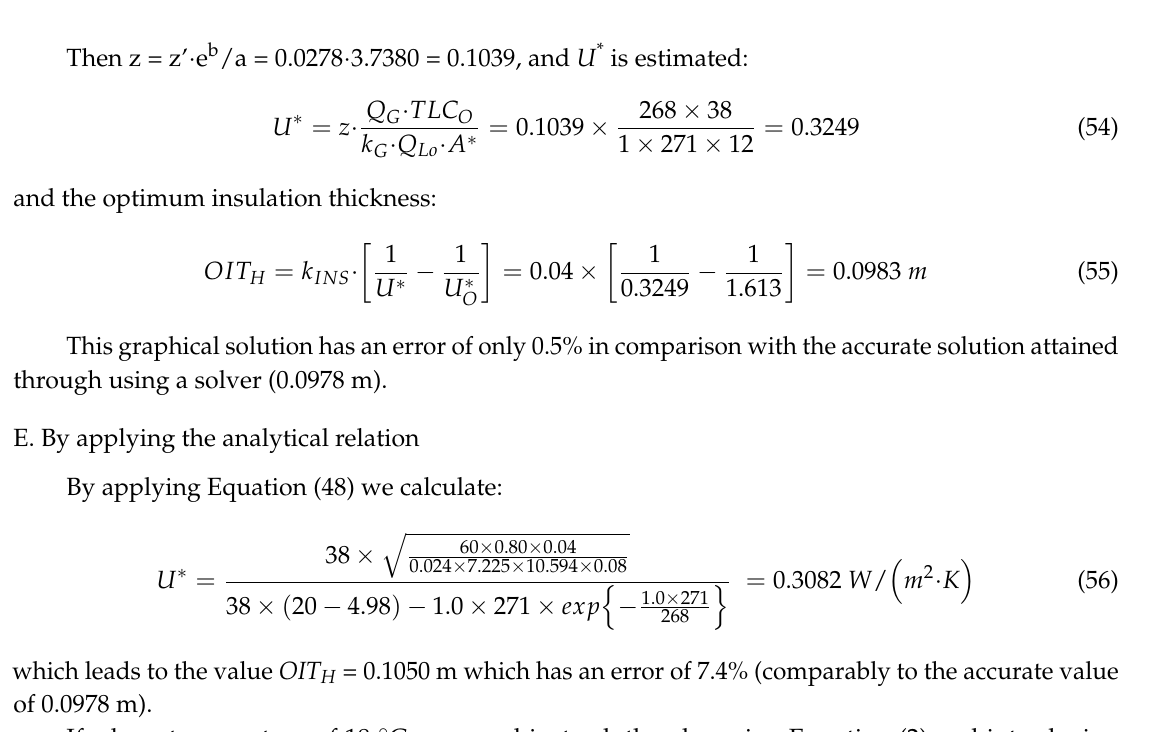
Figure 8. Graphical solution of Equation (53), for the example.